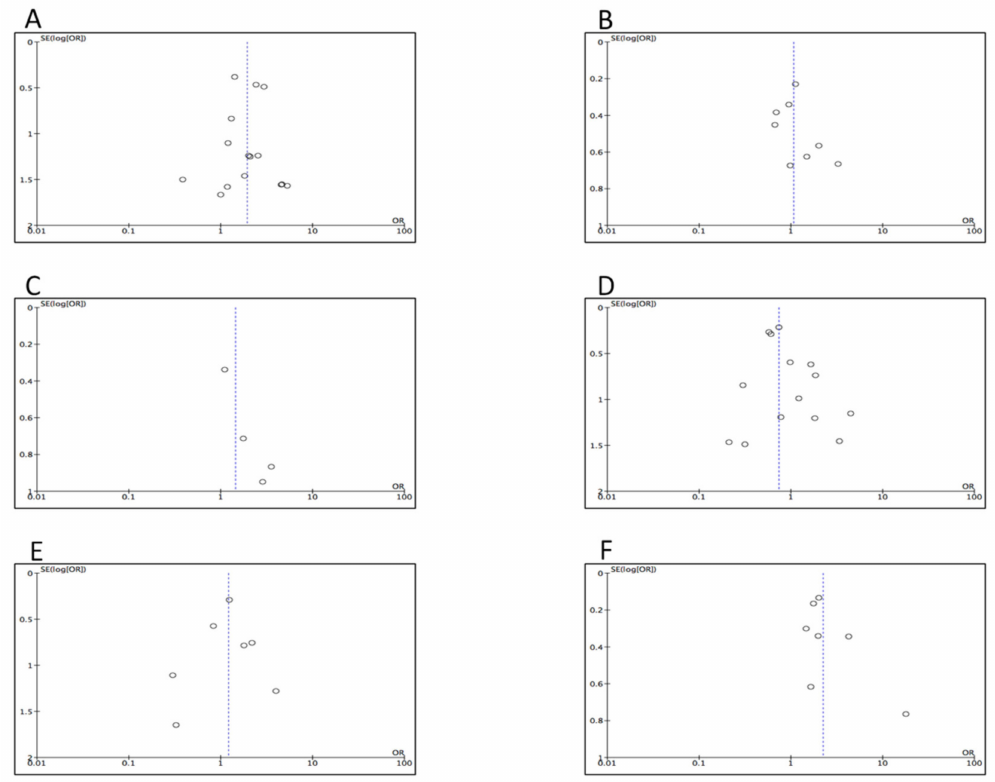
Figure 6. Funnel plots of postoperative outcomes. ( A ) Mortality. ( B ) Overall complications. ( C ) Hemorrage. ( D ) Pancreatic fistula. ( E ) Reoperation. ( F )